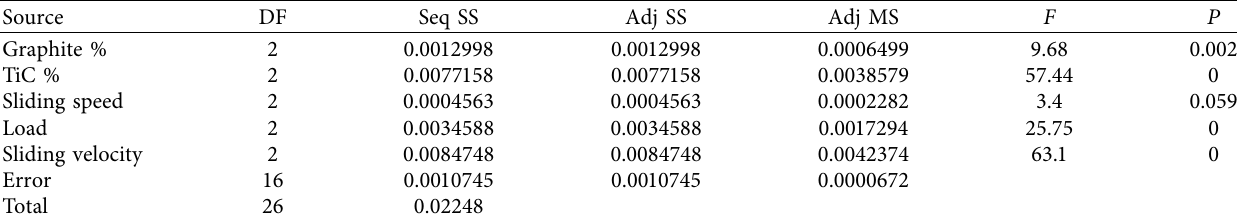
Table 5: ANOVA for COF.